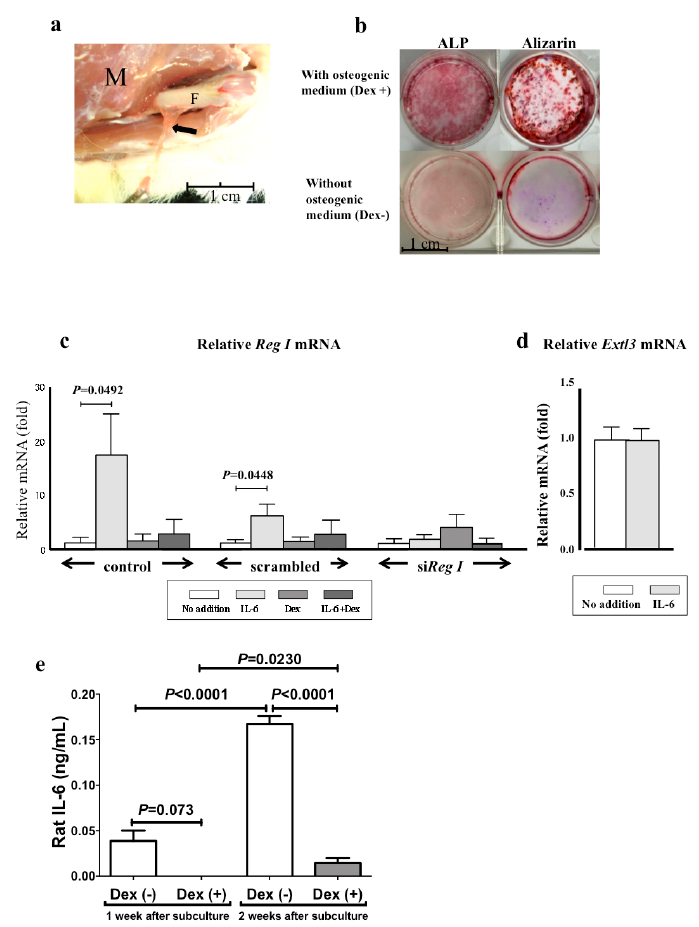
Figure 3. ( a ) Harvesting the periosteum from the femoral bone shaft. The periosteum is easily separated and peeled from the shaft. M: surrounding muscle tissue. F: shaft of the femoral bone. Arrows: periosteum; ( b ) Alkaline phosphatase (ALP) and Alizarin Red S staining of periosteum-derived mesenchymal stem cells (PMSCs) sub-cultured with (upper figures) or without (lower figures)